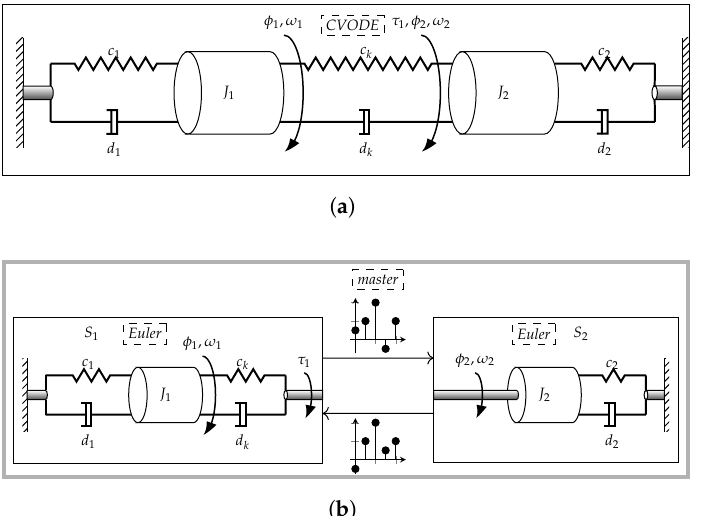
Figure 3. During co-simulation, a co-simulation master orchestrates co-simulation slaves. In the case of the monolithic simulation, a solver solves the entire system of equations: ( a ) Monolithic simulation; ( b )